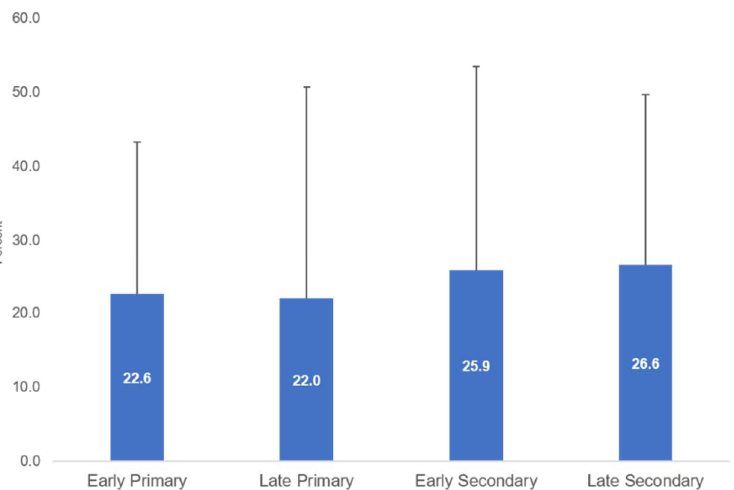
Figure 3. Average percentage of sufficient MVPA of Thai children in 2017–2019, classified by edu- cation.